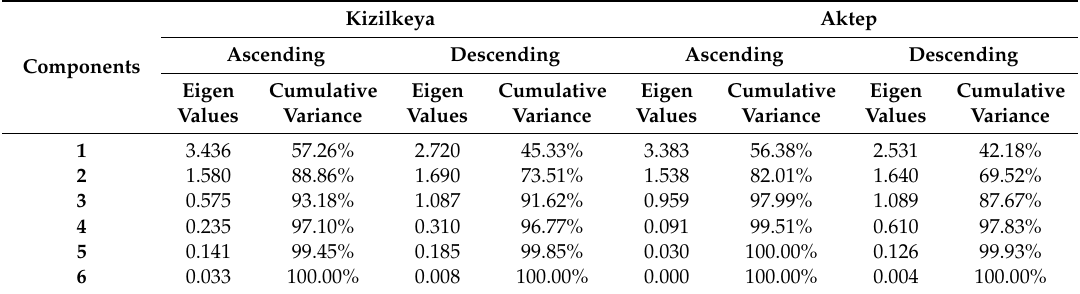
Table 5. Eigenvalues of the correlation matrix and its cumulative contribution rate.